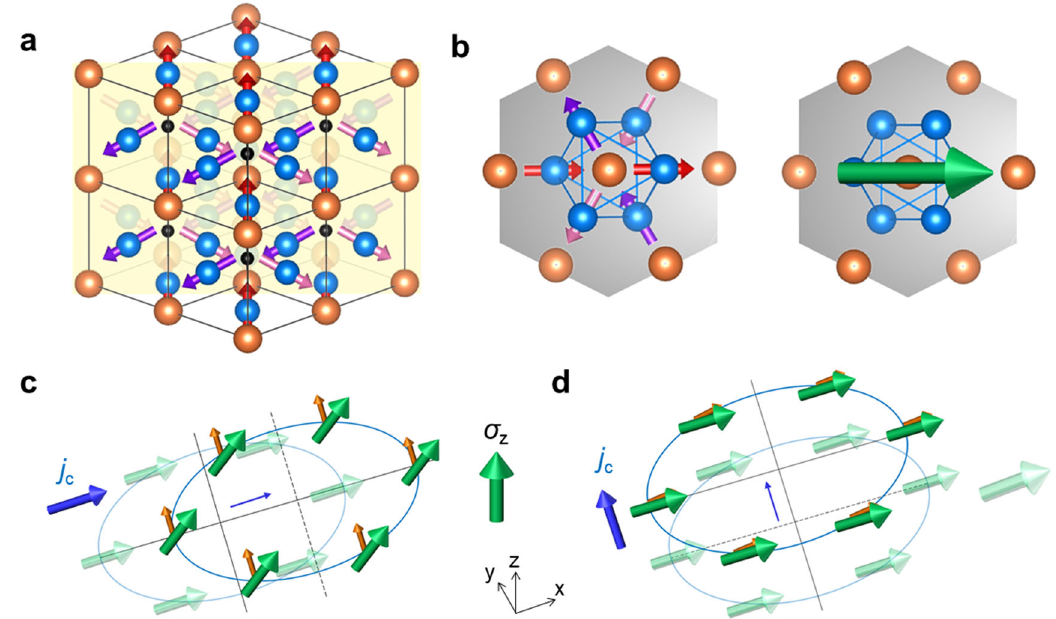
Fig. 1 Generation of σ z in Mn 3 SnN. a Crystal structure of Mn 3 SnN, where the blue, orange, and black spheres represent the Mn, Sn, and N atoms, respectively. Red, purple, and pink arrows denote magnetic moments of Mn atoms, and the yellow plane denotes the (110) plane. b Left, the spin structure of Mn 3 SnN on the kagome bilayers, where the gray plane denotes the kagome (111) plane. Right, the ferroic ordering of a cluster magnetic octupole consisting of six spins is viewed from the spin structure. The green arrow denotes the cluster magnetic octupole moment T . c Carrier spins are rotated by the spin-orbit fi eld H so (brown arrows) when J // T , which induces the spin current with σ z . d Spin rotation and σ z vanish when J ⊥ T . Here, H so is parallel to the carrier spins.